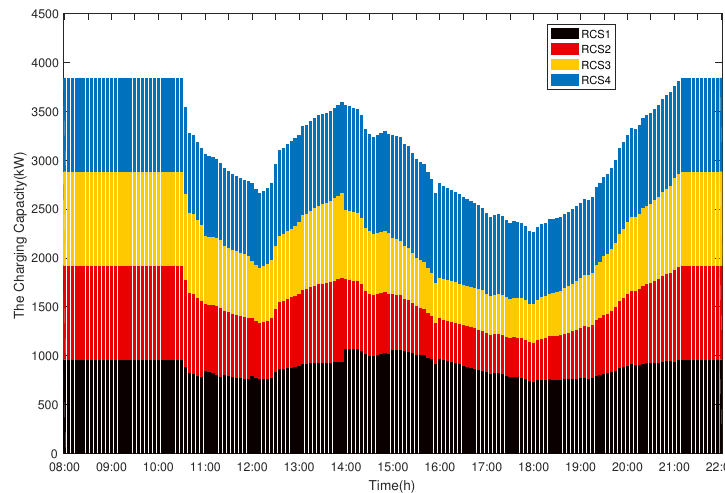
Figure 8. The charging capacity of Rapid-Charging Stations (RCSs) at different time.